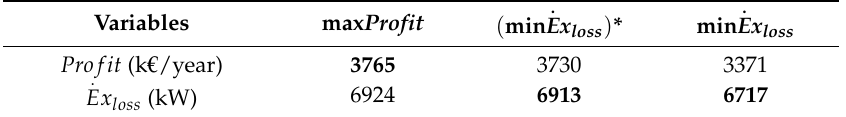
. Ex loss for the three different studied cases. For each case, the value of Table 6. Values of Profit and optimized criteria is in